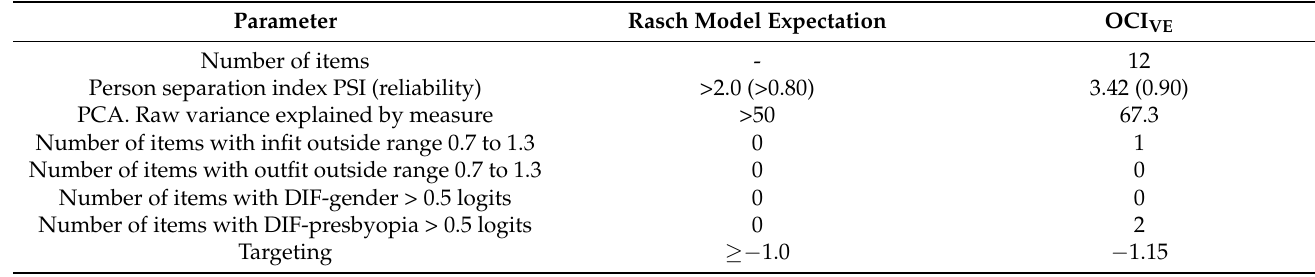
Table 4. Psychometric Properties of OCI VE .